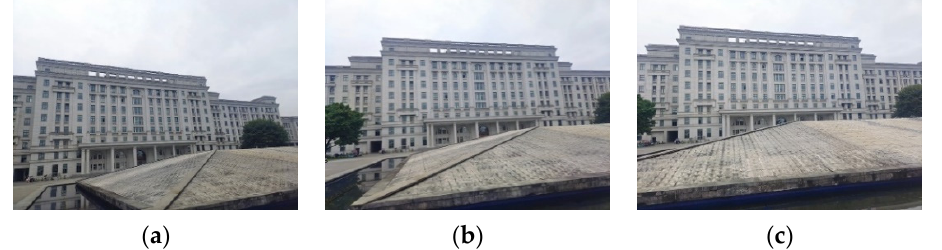
Figure 6. The original multi-angle images of the first scene: ( a ) the 0° image; ( b ) the 15° image; ( c ) the 35° image.